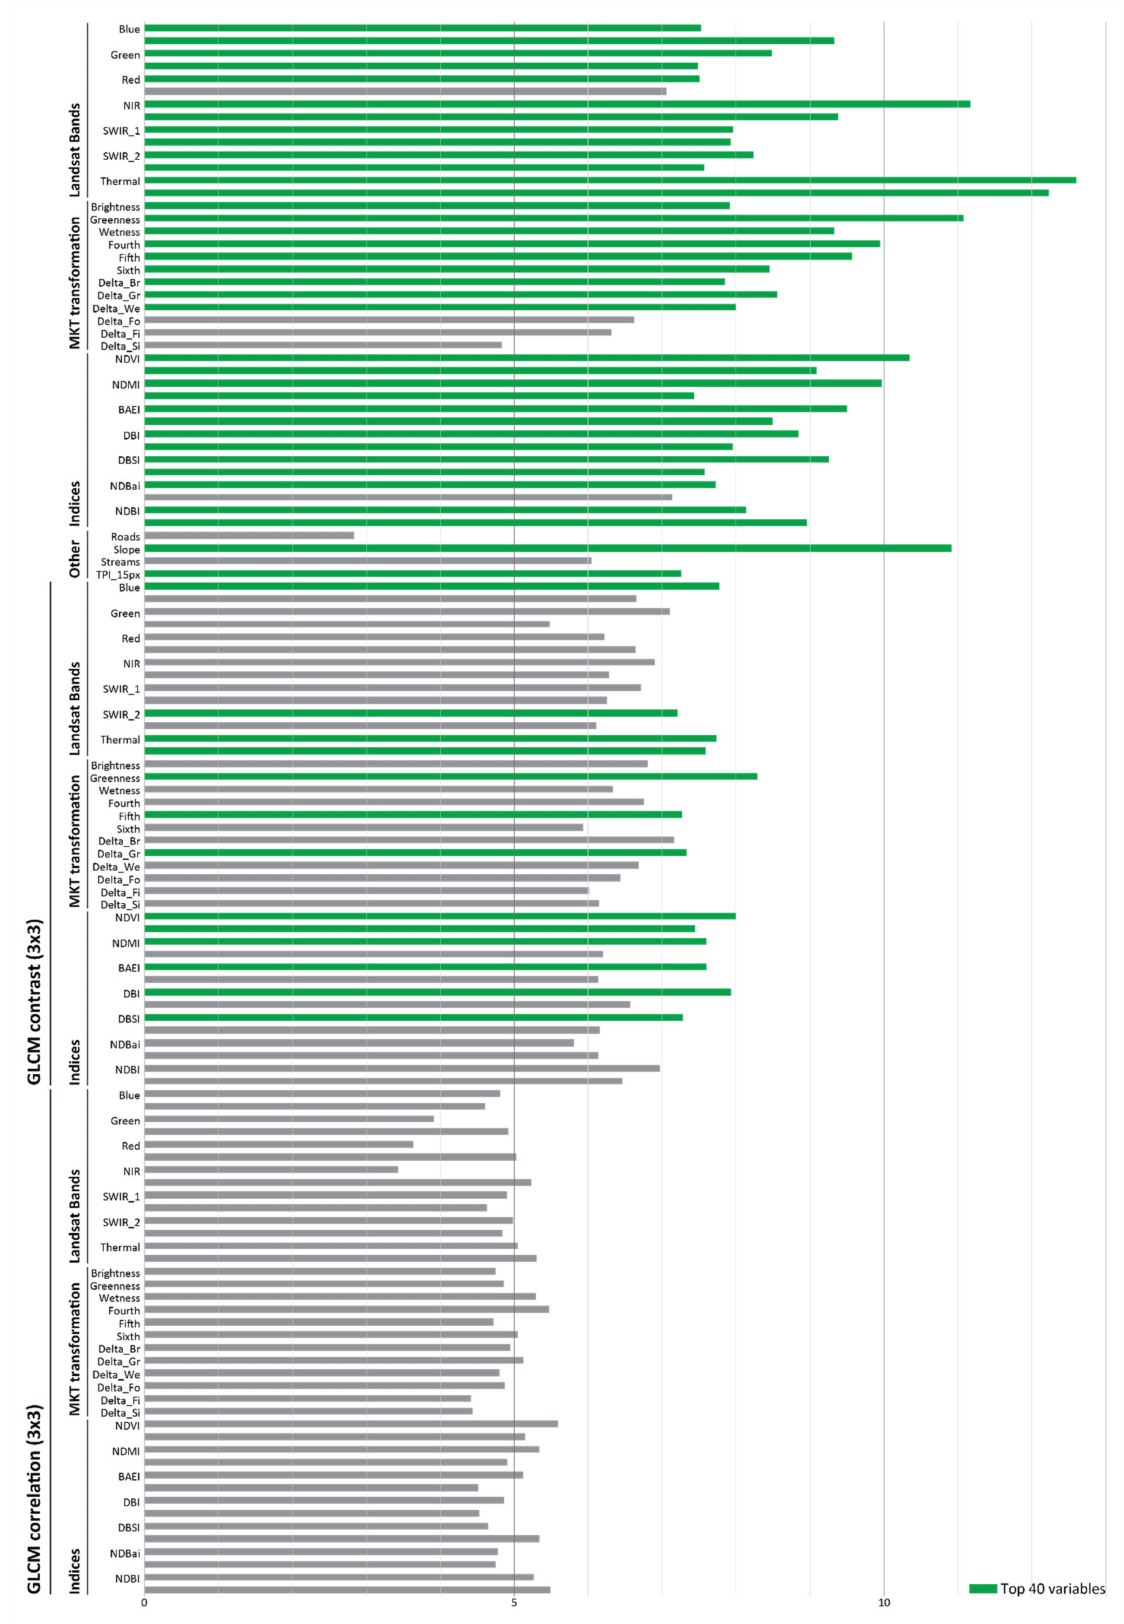
Figure 3. Average variable importance over the 35 yearly Random Forest classification models. Top 40 variables are the ones with the highest mean contribution over our 35 yearly